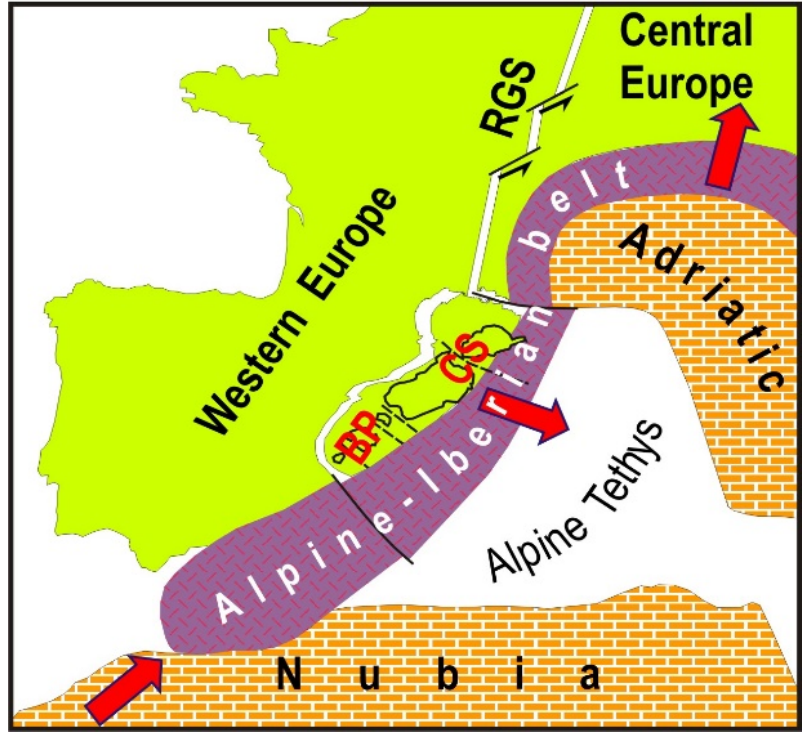
Figure 3. After the collision of the Alpine–Iberian belt with the continental African domain, the Northeastward push of Nubia was transmitted to Central Europe, causing the formation of a sinistral transtensional fault system, running from Western Europe to the Rhine Graben System (RGS). BP = Balearic promontory, CS = Corsica Sardinia.